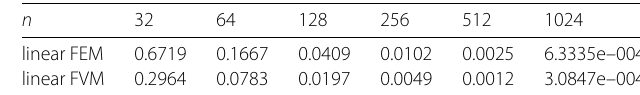
Table 1 The error in the relative discrete L 2 -norm for problem (5.1) with k = 30